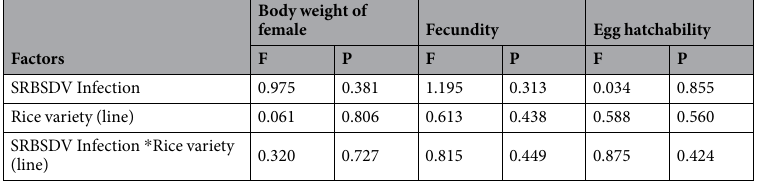
Table 8. ANOVA of effects of transgenic rice plants infected with SRBSDV on the body weight, fecundity of female adult BPH and egg hatchability.